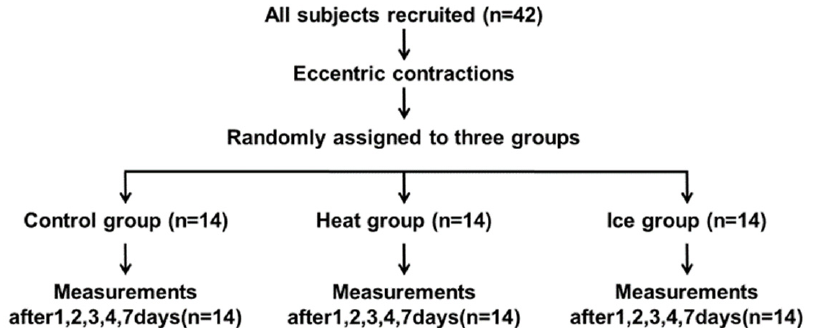
Figure 1. Experimental design and protocol. A total of 42 healthy university students were allocated to one of the three treatment groups; in the Control group, the participants rested for 30 min; in the HEAT group, the participants underwent 30-min microwave irradiation at 80 W from a distance of about 15 cm; in the ICE group, the participant’s elbow was placed on a pillow, and the elbow flexor muscles were immobilized with the icebag for 30 min ( n = 14 per group)–all groups were placed in the supine position with the shoulder joint in 90° abduction and 45° external rotation and the elbow joint in extension during treatment. The elbow joint was placed in extension. All groups underwent various measures before and after the muscle damage protocol, after treatment, and 1–4 and 7 days after the muscle damage protocol.